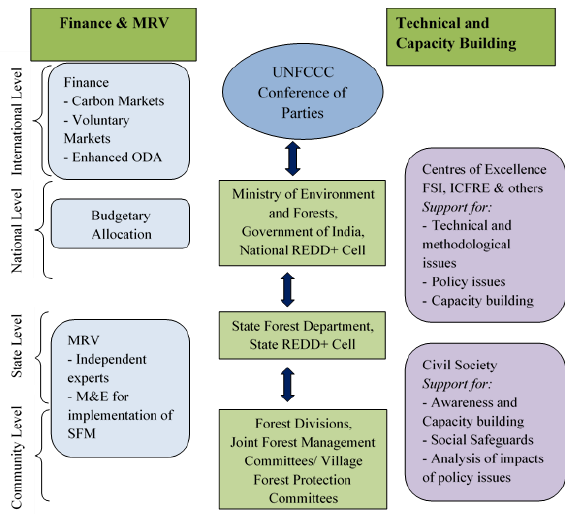
Figure 8. REDD+ institutional framework [36] National